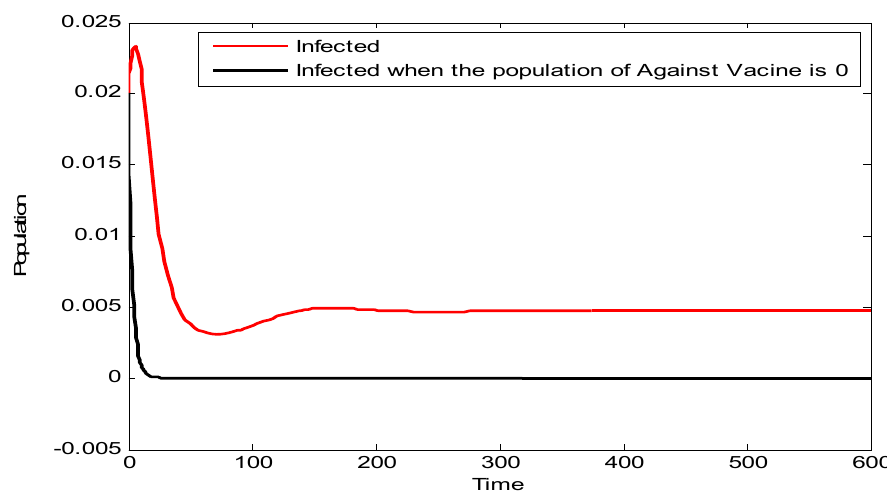
Figure 3. Effect of eliminating the anti—vaccine population.